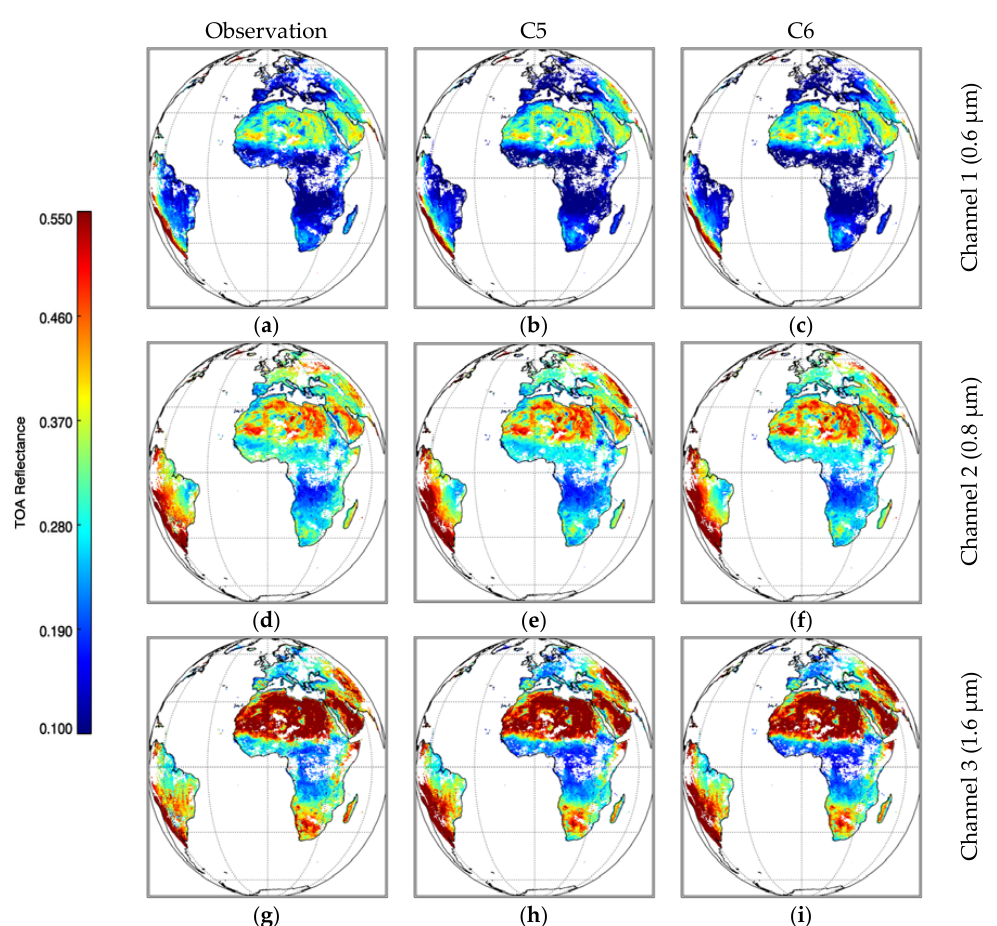
Figure 3. Observed and simulated top of atmosphere (TOA) clear-sky reflectance in three Spinning Enhanced Visible and InfraRed Imagers (SEVIRI) solar channels: ( a – c ) Observed, simulated with C5, and simulated with C6 for channel 1 at 0.6 microns, respectively; ( d - f ) Observed, simulated with C5, and simulated with C6 for channel 2 at 0.8 microns, respectively; ( g – i ) Observed, simulated with C5, and simulated with C6 for channel 2 at 1.6 microns.